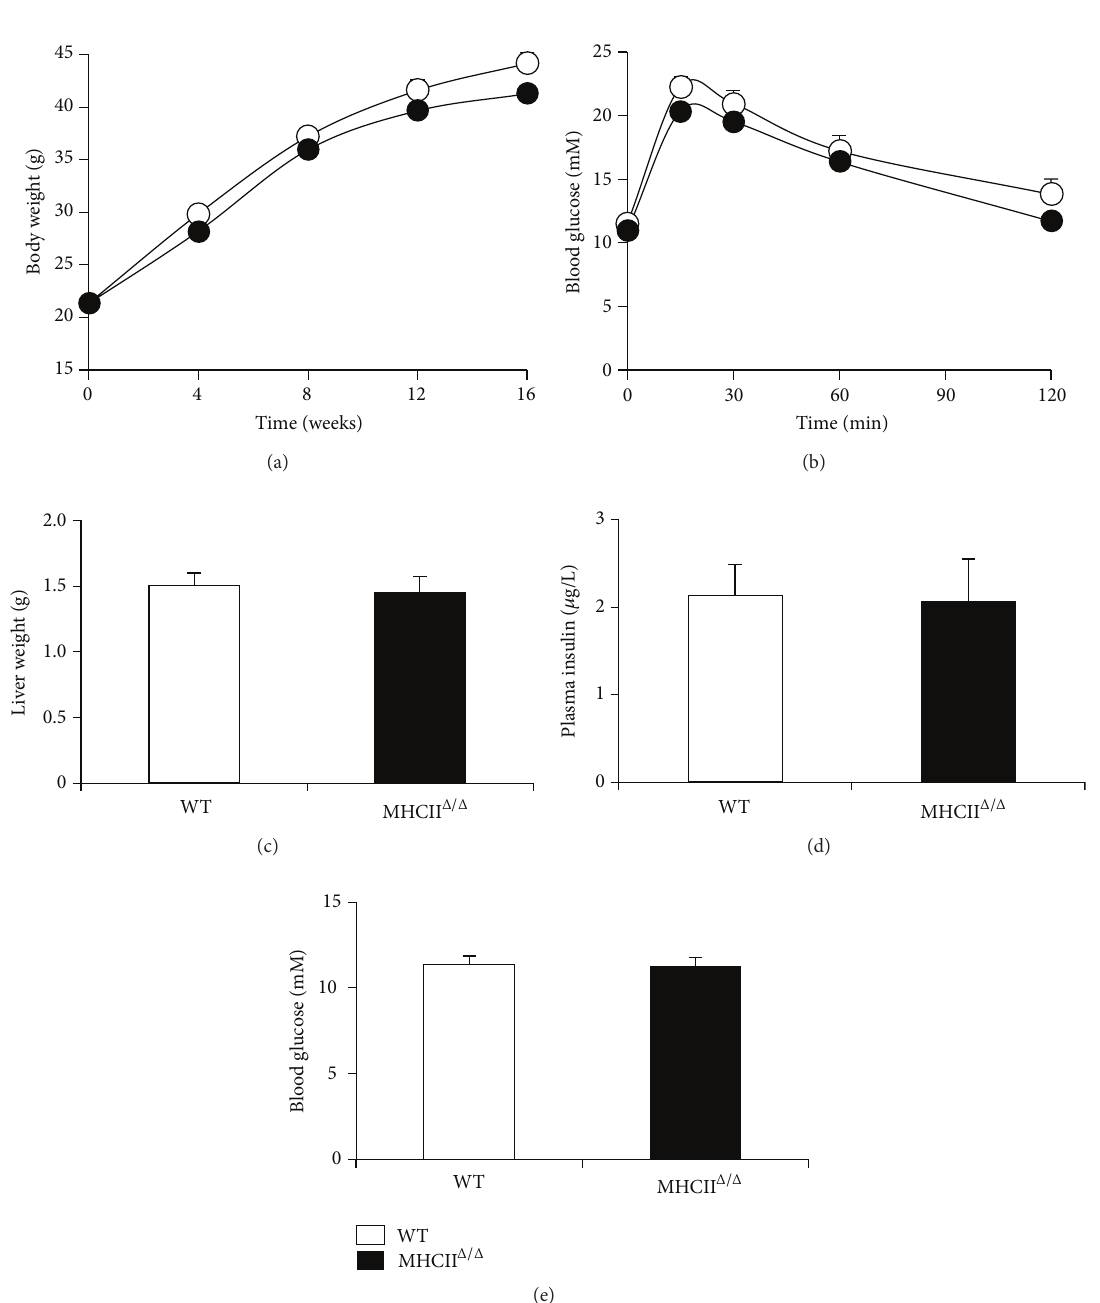
Figure 2: Effect of high-fat diet on metabolic parameters in wild-type and MHCII Δ/Δ mice. Open circle/bars represent wild-type and closed circle/bars MHCII Δ/Δ mice (wild-type: 𝑛 = 25 , MHCII Δ/Δ : 𝑛 = 20 ). Data are presented as mean ± SEM. (a) Body weight gain during 4-month diet. (b) Glucose tolerance test was performed around the 15th week of the intervention. (c) Liver weight at 16th week. (d) Fasting plasma insulin concentration at 16th week. (e) Fasting blood glucose concentration at 16th